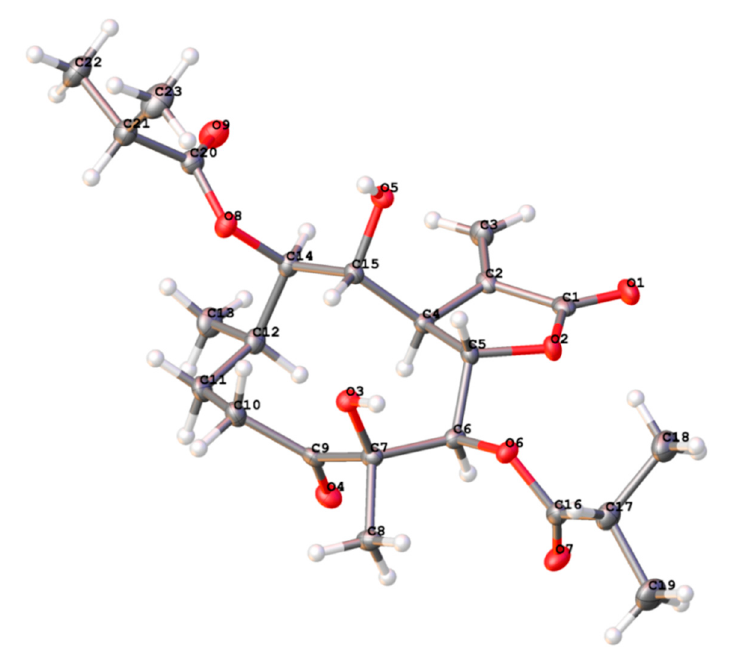
Figure 3. X-ray ORTEP drawing of 1 .